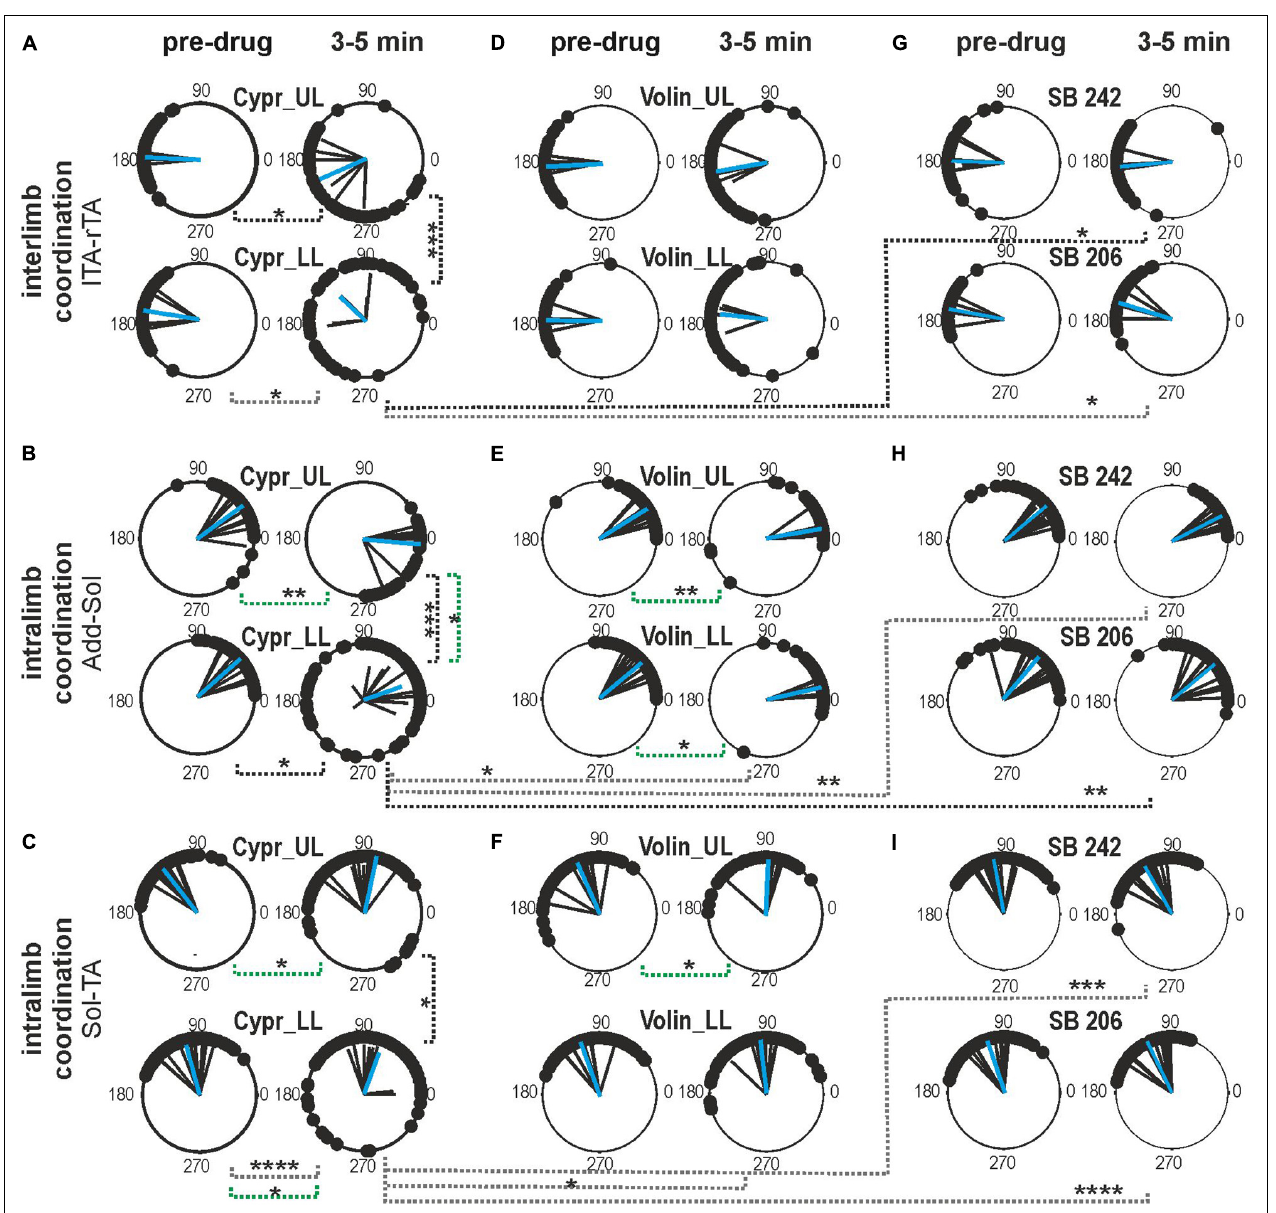
FIGURE 5 | Inter- and intralimb coordination after blockade of various 5-HT receptors by either Cyproheptadine (A–C) , Volinanserin (D–F) , SB 242084 or SB 206553 (G–I) application in the upper lumbar (UL) or low lumbar (LL) spinal cord. (A,D,G) Polar plots show interlimb (established between left vs . right TA muscles) and (B,C,E,F,H,I) intralimb coordination – black vectors are established for each pair of muscles in individual animals; blue vectors are the mean for the group of animals. Particular dots in the polar plots illustrate the phase shift between analyzed EMG bursts of two different muscle onsets: interlimb coordination (lTA vs . rTA) or intralimb coordination (Add vs . Sol or Sol vs . TA). Concentrated ( vs. dispersed) distribution of single dots on the polar plots confirms strong ( vs. weak) coupling in the two analyzed muscle EMG bursts. The length of the vector ( r , ranging from 0 to 1) indicates the strength of coordination between analyzed muscle burst onsets demonstrating the concentration of dots around the mean. The angle of the r -vector illustrates the phase shift between analyzed muscle burst onsets of particular muscle coordination. For more details, see description in the “Materials and Methods” section. Note the well pronounced effect of Cypr in contrast to lack of an effect of Volin in interlimb coordination after application in the low lumbar segments ( A vs. D ). The strength of adductor vs. soleus intralimb coordination (B,E) and soleus vs. tibialis anterior intralimb coordination (C,F) was significantly affected by Cypr in LL rats but not by Volin or by SB 242 and SB 206 drug application (black doted lines). The phase shift was significantly altered only by Cypr in UL and LL rats (green doted lines), but not by Volin or SB 242 and SB 206. Statistical significance for difference of the strength and phase shift of inter- and intralimb coordination was established in the different groups of animals using nonparametric Kruskal-Wallis test followed by Dunn’s multiple comparisons (* p < 0.05; ** p < 0.01; *** p < 0.001; **** p < 0.0001). Results from left and right muscles were pooled in all the rats in the various experimental conditions, so the number of samples taken for analysis were: Cypr_UL n = 12, Cypr_LL n = 10, Volin_UL n = 10, Volin LL n = 10, SB 242 n = 12, SB 206 n = 10. Add, adductor muscle; Sol, soleus muscle; lTA/rTA, left/right tibialis anterior muscle; Cypr, Cyproheptadine; Volin, Volinanserin; SB 242, SB 242084; SB 206, SB 206553; UL, upper lumbar segments (L2/L3); LL, low lumbar spinal cord (L5/L6).